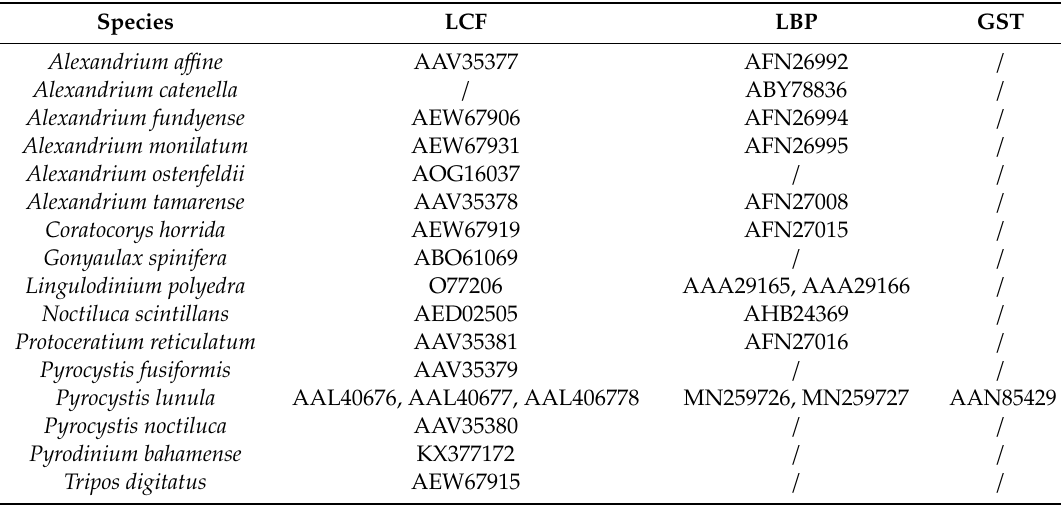
Table 1. Accession numbers of the sequences reported in GenBank for the luciferase (LCF), luciferin binding protein (LBP) and glutathione S-transferase (GST) in the species of microalgae. Species